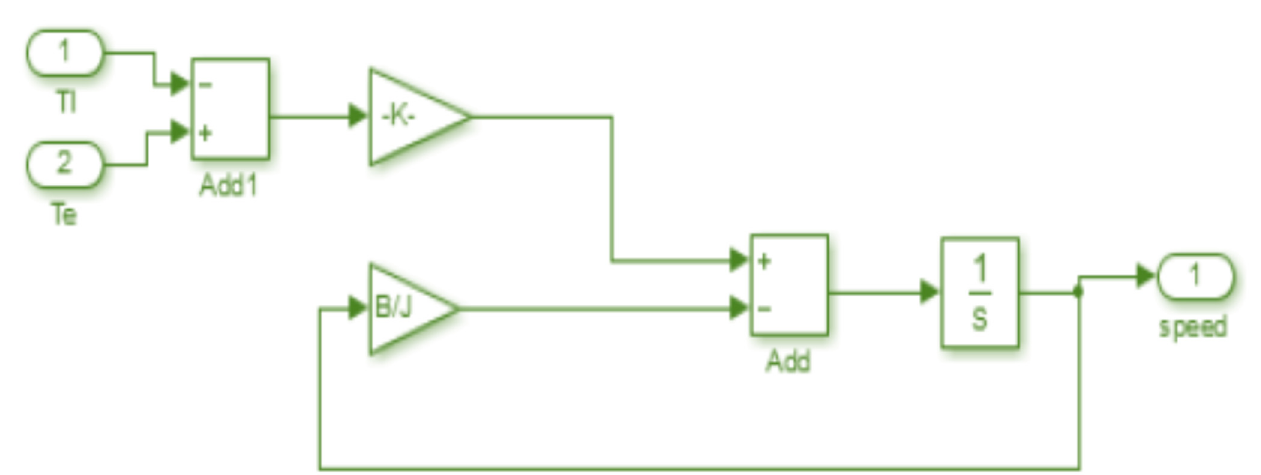
Figure 8. Load for dynamic modeling.